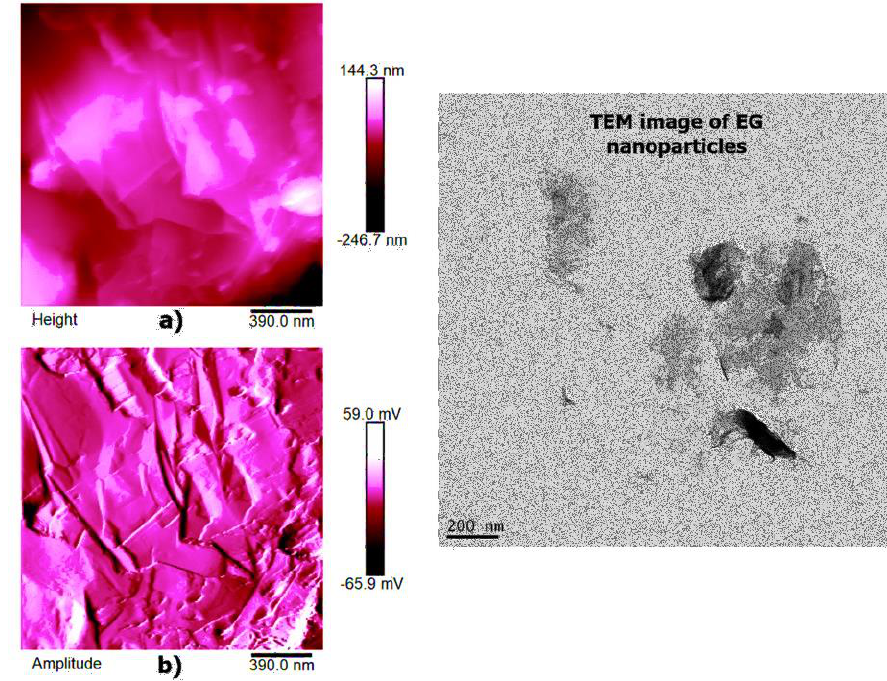
Figure 15. Tapping mode high-resolution AFM micrographs of the fracture surface of the TBD+3%EG sample (see on the left: ( a ) height profile, ( b ) amplitude profile) and the TEM micrograph of EG nanoparticles (see on the right). Polymers 2019 , 11 , x FOR PEER REVIEW